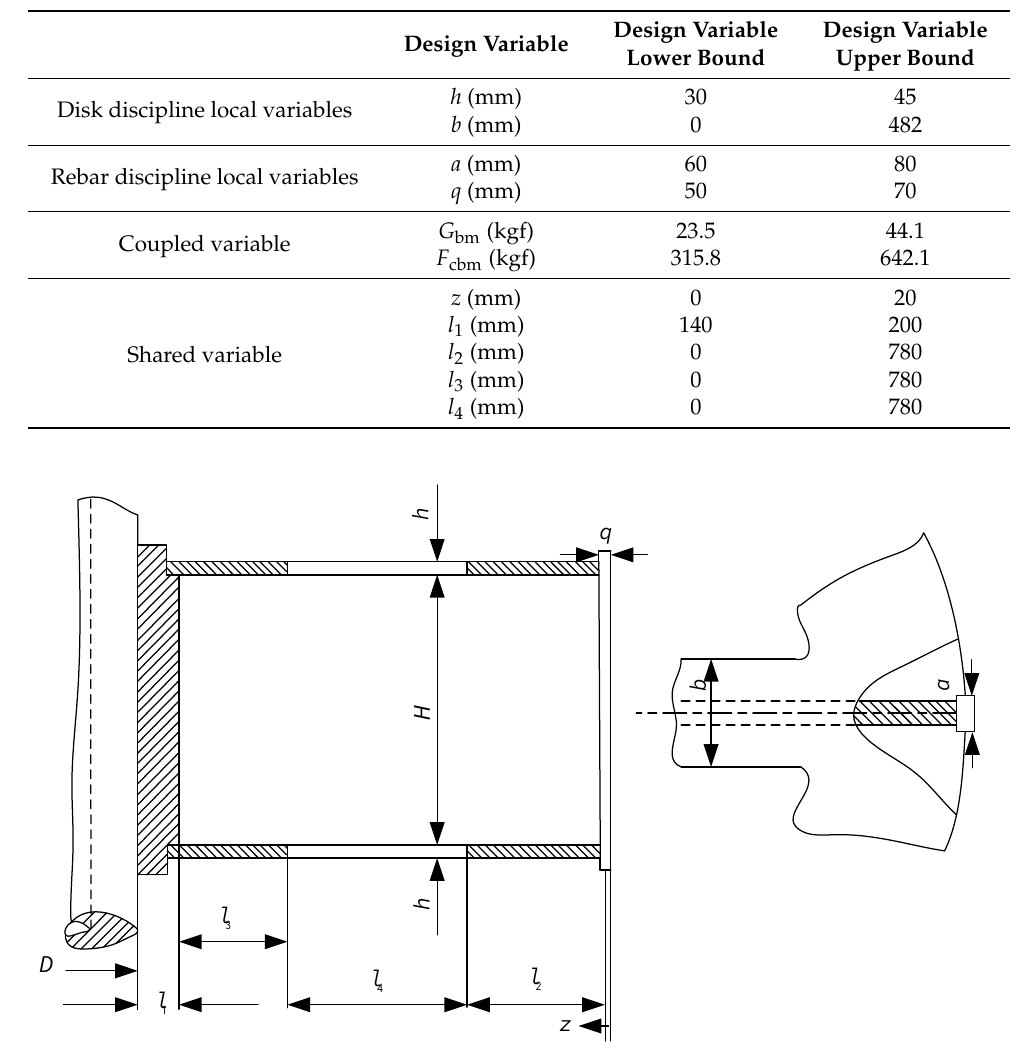
Figure 6. Schematic diagram of the actual meaning of the design variables.